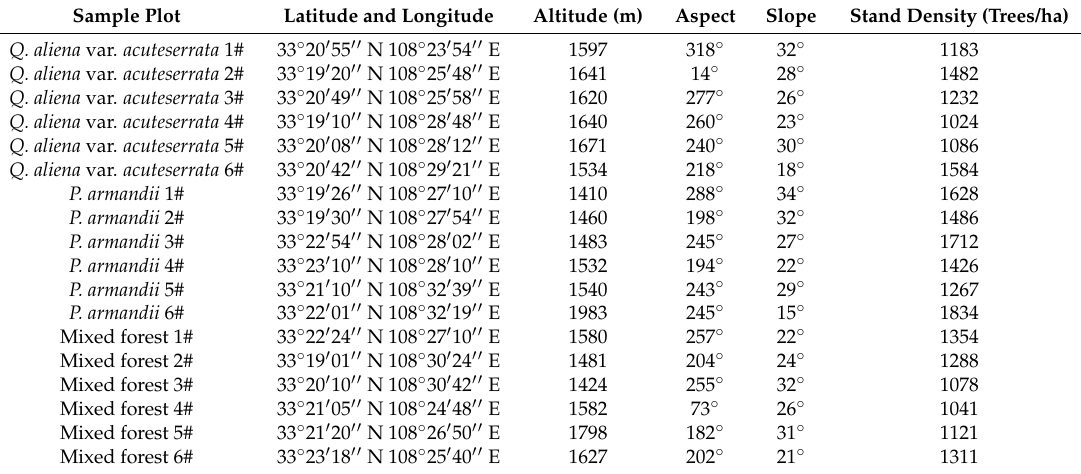
Table 1. Plot characteristics in the main types of forests at the Huoditang Experimental Forest Farm in the Qinling Mountains,